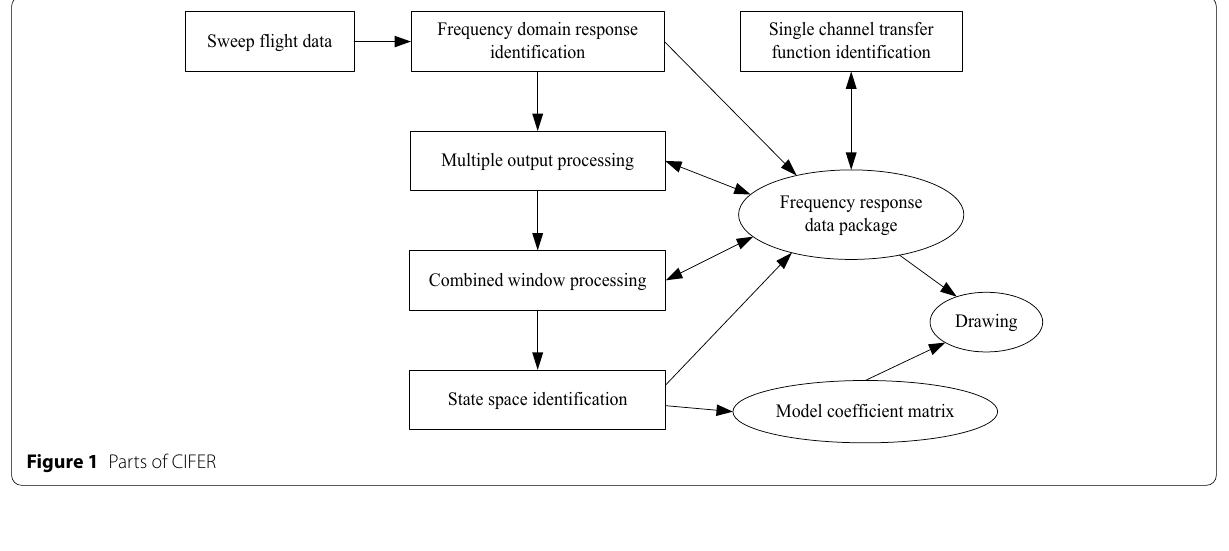
Figure 1 Parts of CIFER